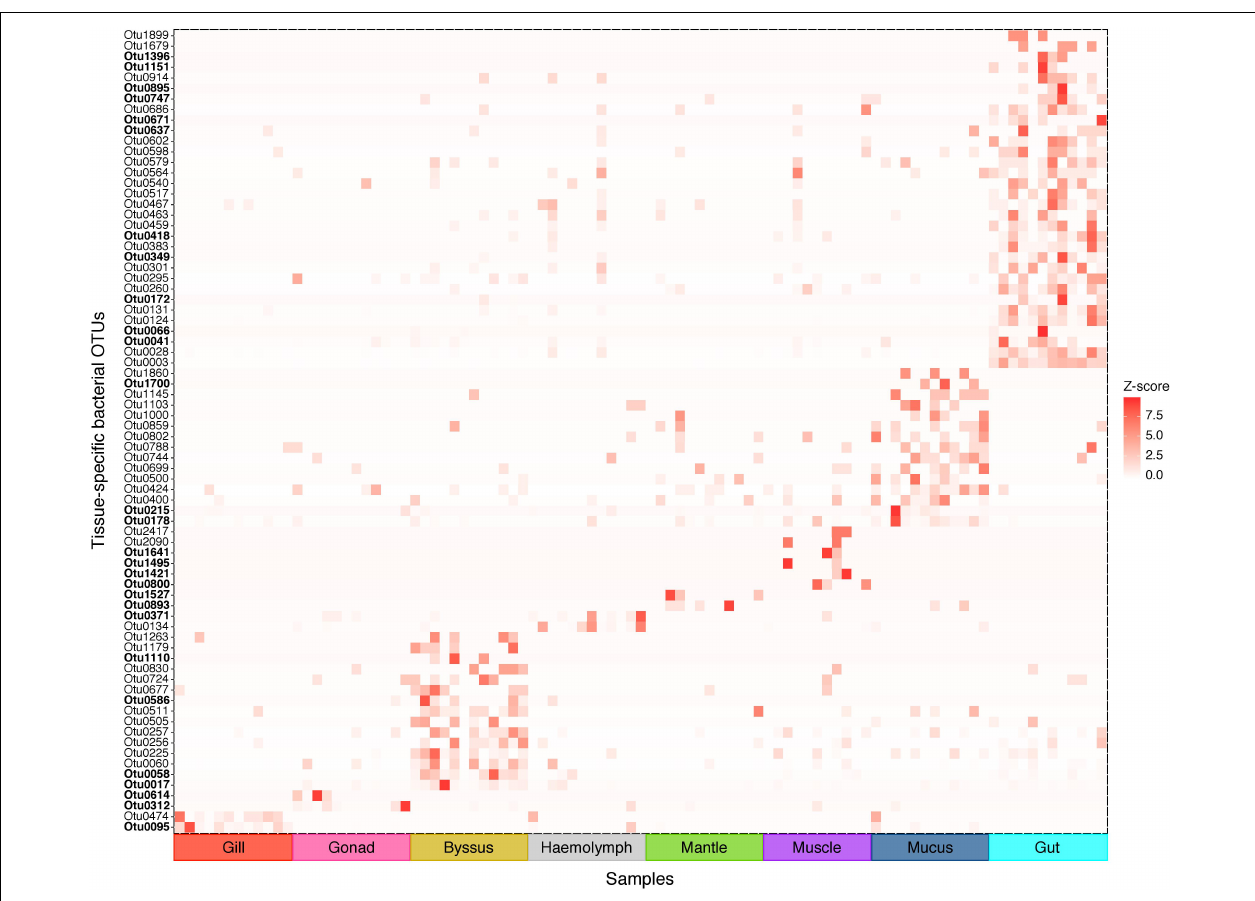
FIGURE 4 | Indicator bacterial OTUs for variation in bacterial communities between P. margaritifera tissues. Heatmap based on IndicSpecies analysis shows specific bacterial OTUs that characterise each tissue. Each cell represents the standard transformation of the counts for each specific OTU per tissue. Bold OTUs indicate highly tissue-specific OTUs with Z -scores > 7.5. See Supplementary Data S4 for details on IndicSpecies analysis and Z -score